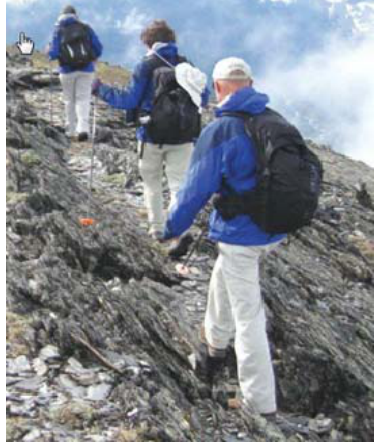
Irvine, D. Zoomer Magazine 07/2012, p. 105.